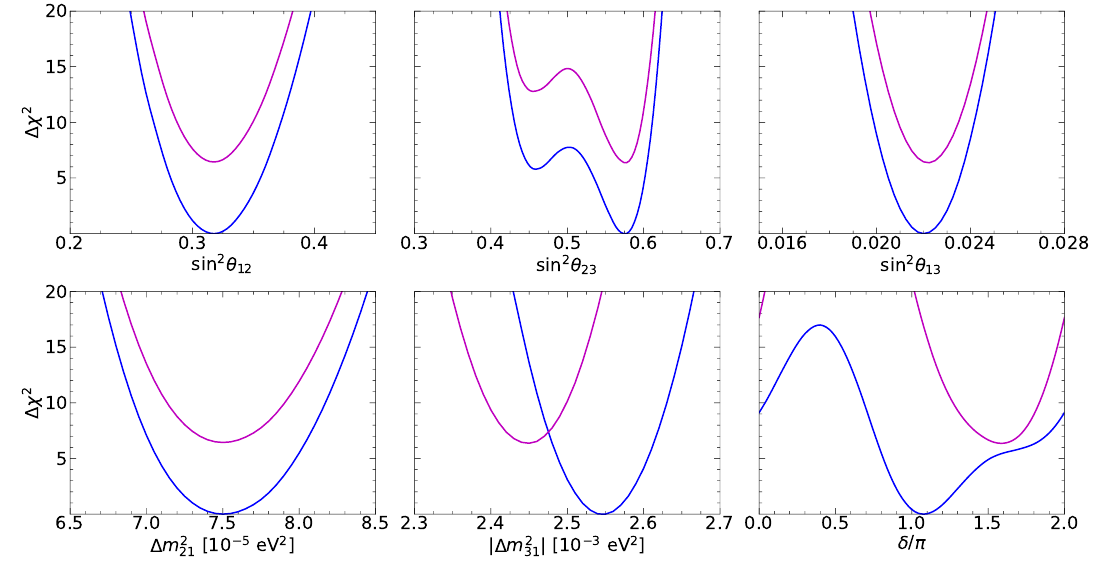
Figure 15 . Overall summary of neutrino oscillation parameter determinations. Blue lines corre- spond to NO and magenta lines to